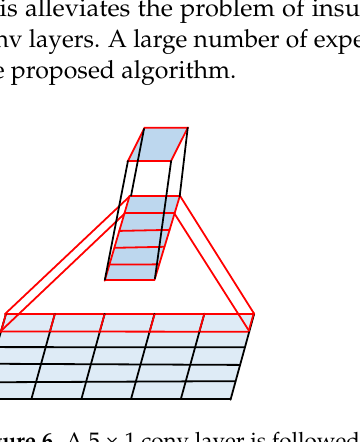
Figure 6. A 5 × 1 conv layer is followed by a 1 × 5 conv